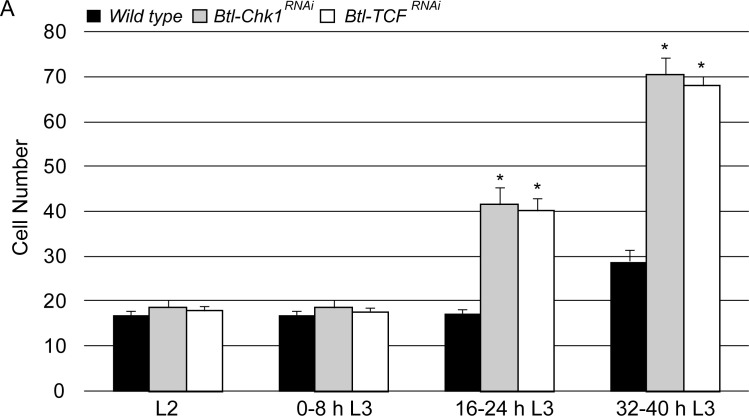
Loss of Chk1 or Wnt signaling leads to continuous proliferation of tracheoblasts through L3.(A) Impact of knockdown of Chk1 and TCF on cell numbers in Tr2 DT. Graph shows cells numbers in wild type (btl-GAL4), Btl-Chk1RNAi (btl-GAL4/UAS-Chk1RNAi), and Btl-TCFRNAi (btl-GAL4/+; UAS-TCFRNAi/+) at L2, 0–8 h L3, 16–24 h L3 and 32–40 h L3. (L2 and 16–24 h L3 data same as Figure 1B, mean values ± standard deviation, n ≥ 7 tracheae) Student's paired t-test: *p<0.05.